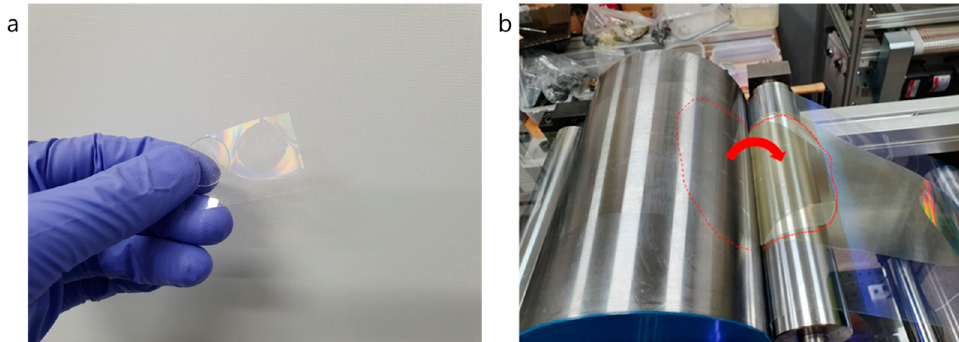
Figure 1. Optical images of the defects due to the high adhesion of the cured NOA76 in demolding process using polyurethane acrylate (PUA) soft mold without surface treatment. ( a ) The PUA pattern detached from the PUA soft mold; ( b ) The PUA soft mold peeled off from imprint roll in roll to roll (R2R) imprinter.